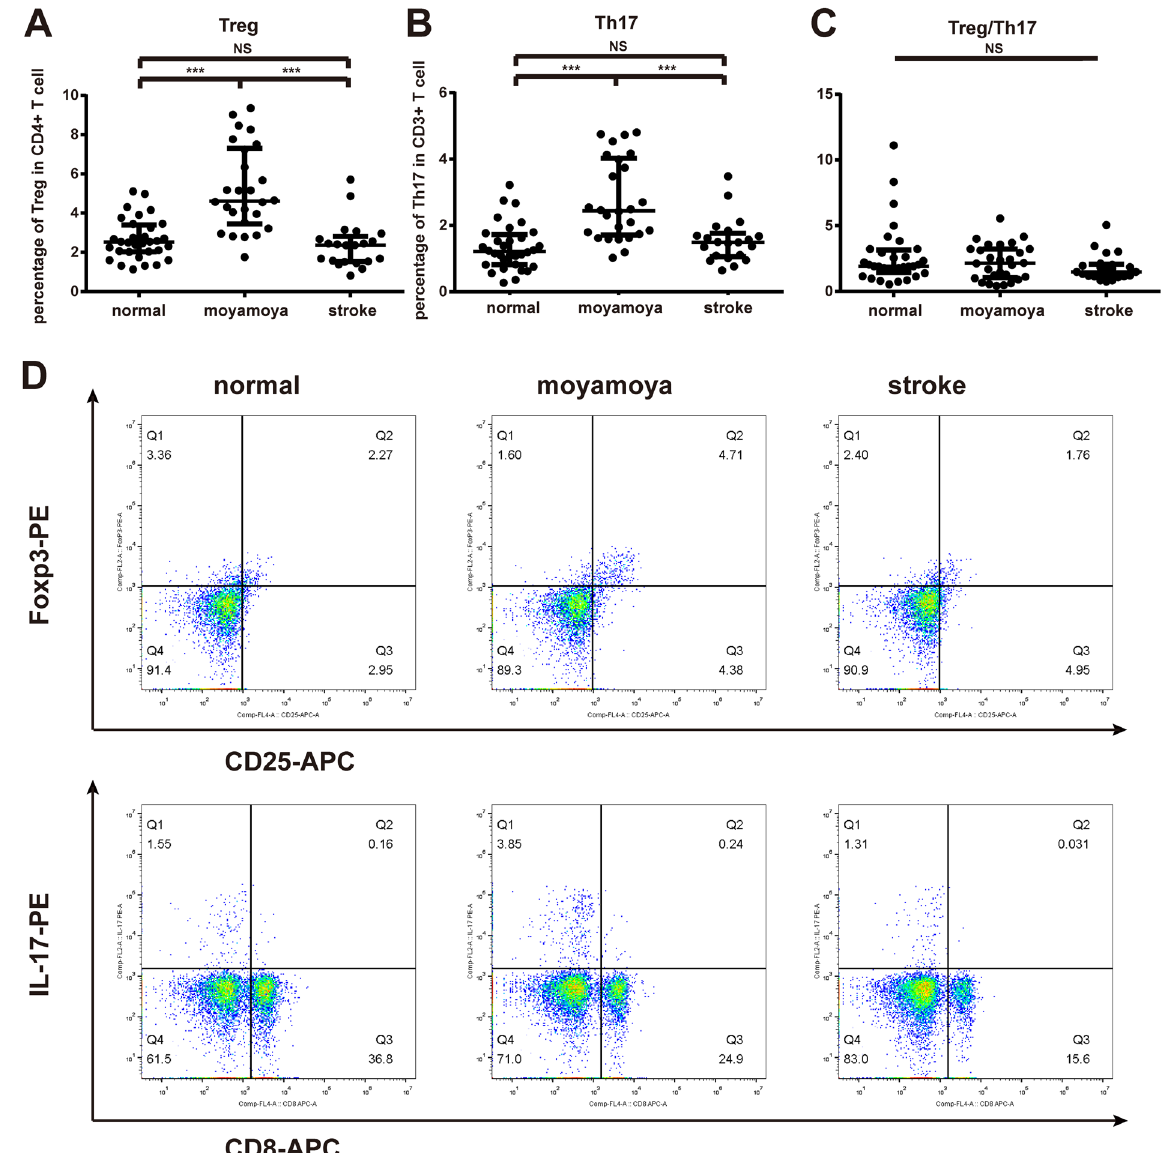
Figure 1. The percentage of peripheral Treg and Th17 cells in MMD patients, atherothrombotic stroke patients and controls. Both the levels of Treg and Th17 were significantly increased in MMD patients compared to other groups. ( A , B ) Representative FACS plots for Treg and Th17 cells in peripheral blood. ( C ) The ratio of Treg/Th17 among the three groups. ( D ) Each bar represents the median and quartiles of three independent experiments. * P < 0.05, ** P < 0.01 and *** P <